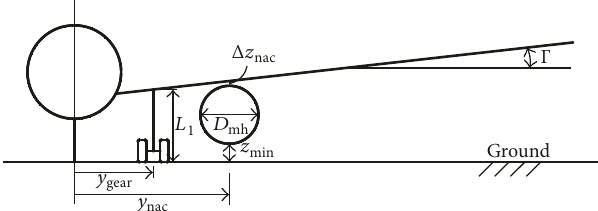
Table 1: Results of DOC components for baseline